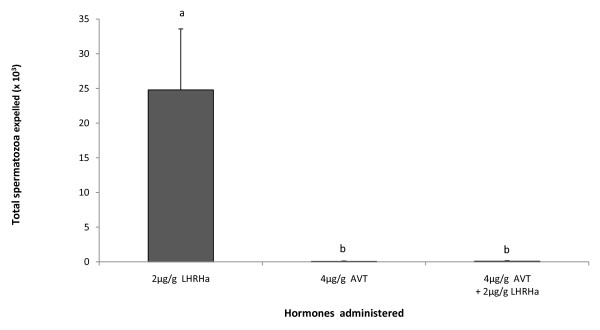
Total number of spermatozoa (× 103) released by males administered LHRHa (n = 10), AVT (n = 7) and AVT + LHRHa (n = 7) over a 12 h sampling period. Data shown are untransformed mean ± SEM. Letters displayed are the result of a Tukey Kramer HSD post-hoc test of Log10 (× +1) transformed data. Treatments that share a letter are not significantly different from each other.